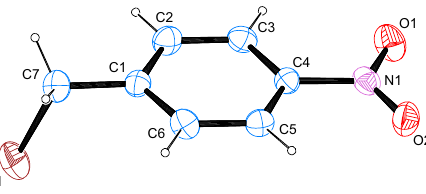
Table  : Data collection and handling.